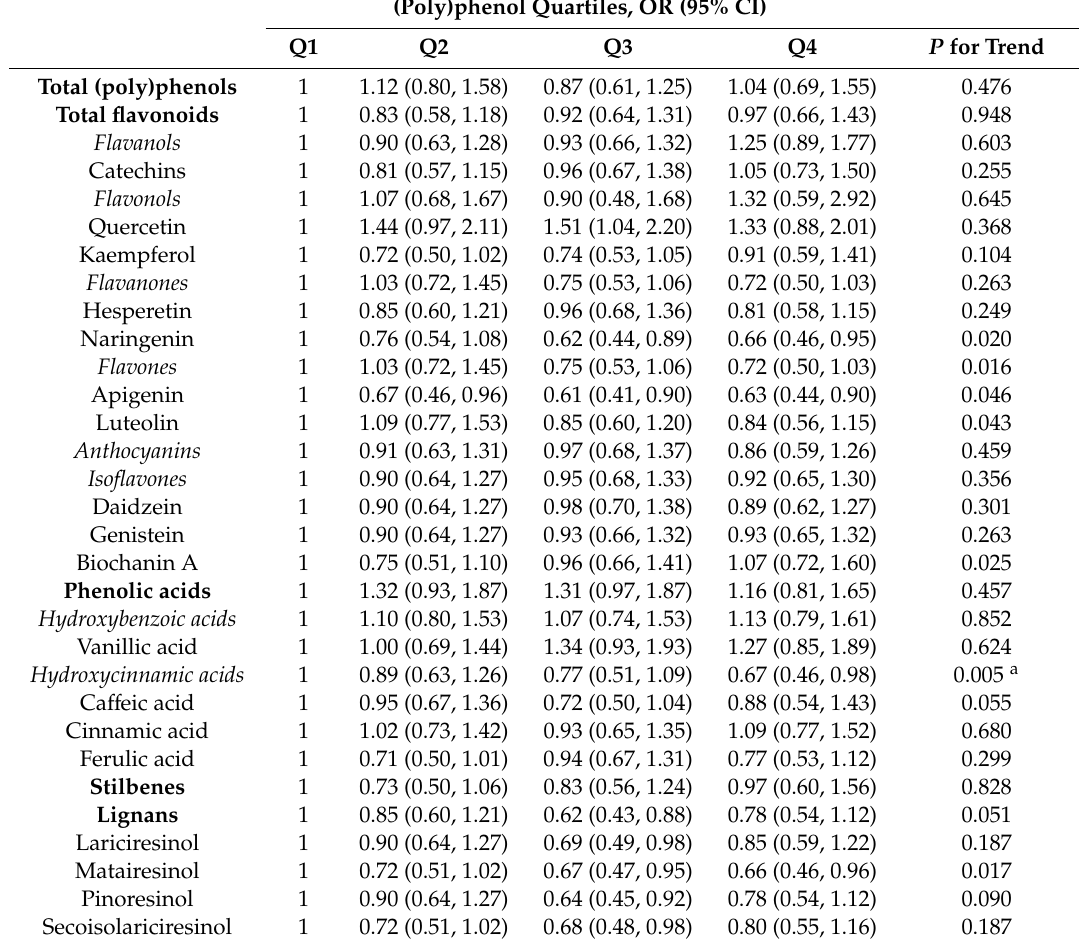
Table 2. Odds ratios (ORs) and 95% confidence intervals (CIs) for the associations between (poly)phenol intake (total, main classes, subclasses and individual compounds) and adequate sleep quality in the MEAL